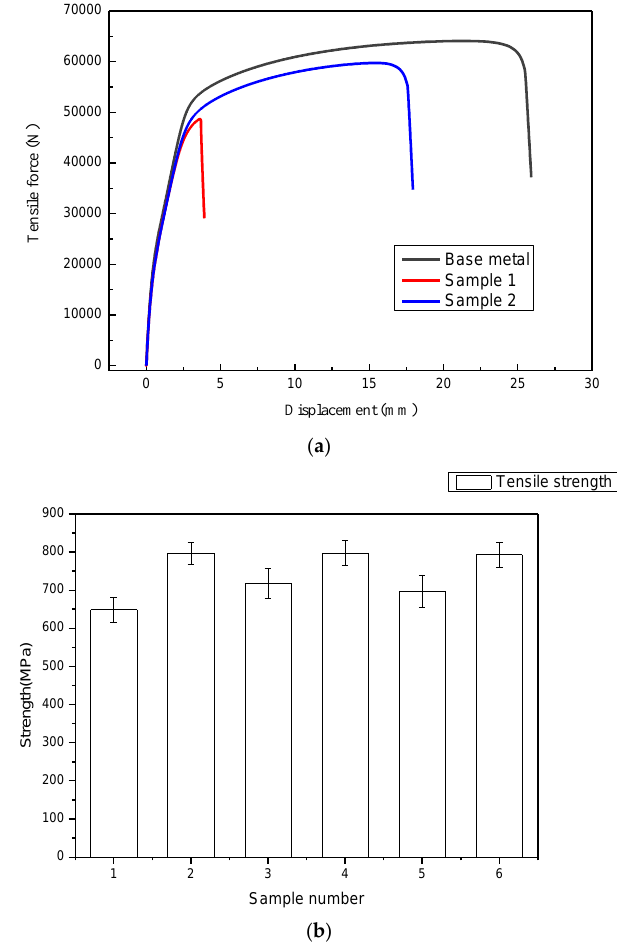
Figure 7. Tensile properties of the base metal and welded joint: ( a ) Tensile curves, ( b ) Result of tensile tests.